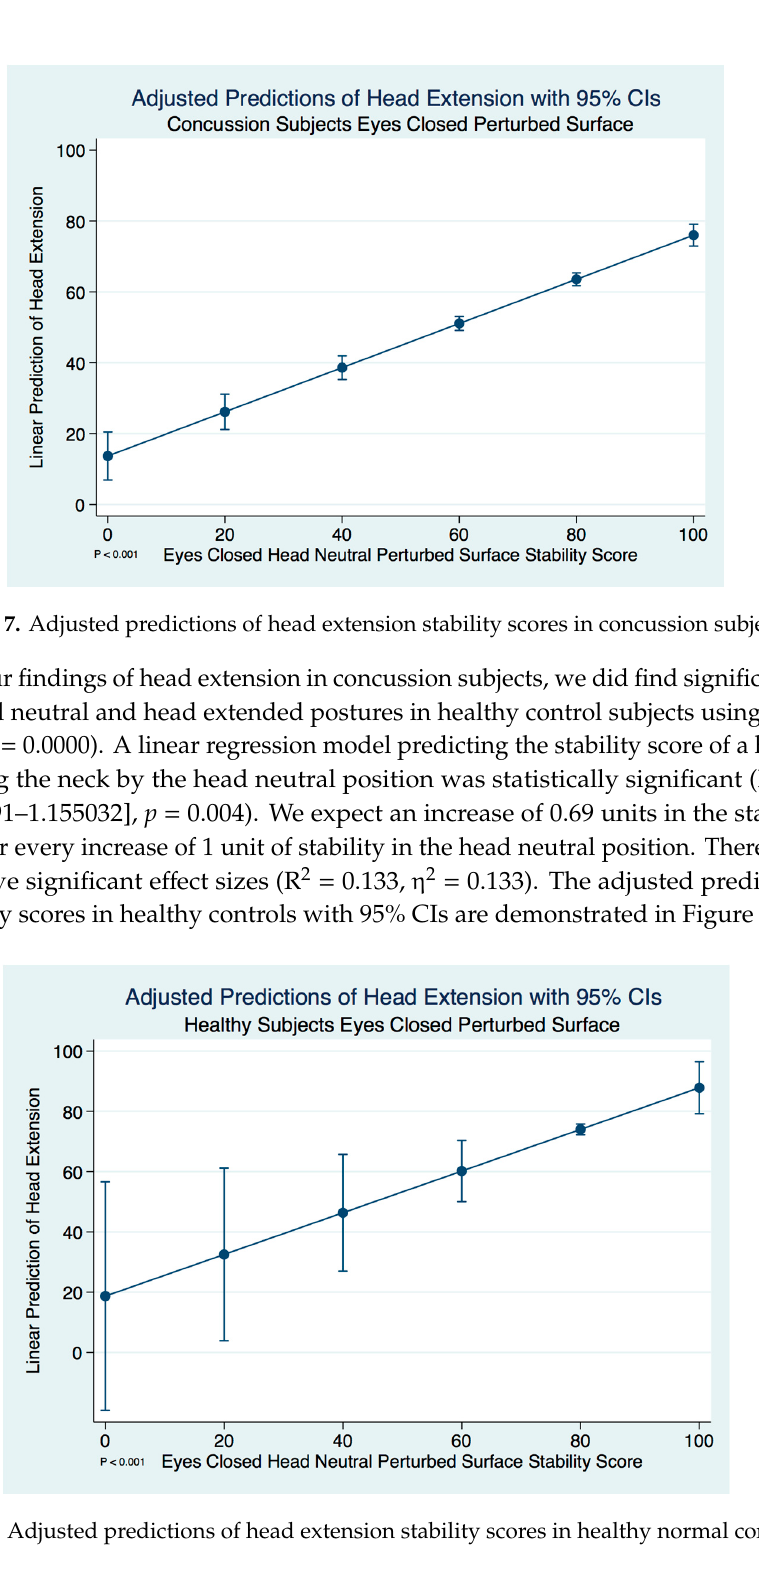
Figure 6. Adjusted predictions of head flexion stability scores in healthy normal controls.